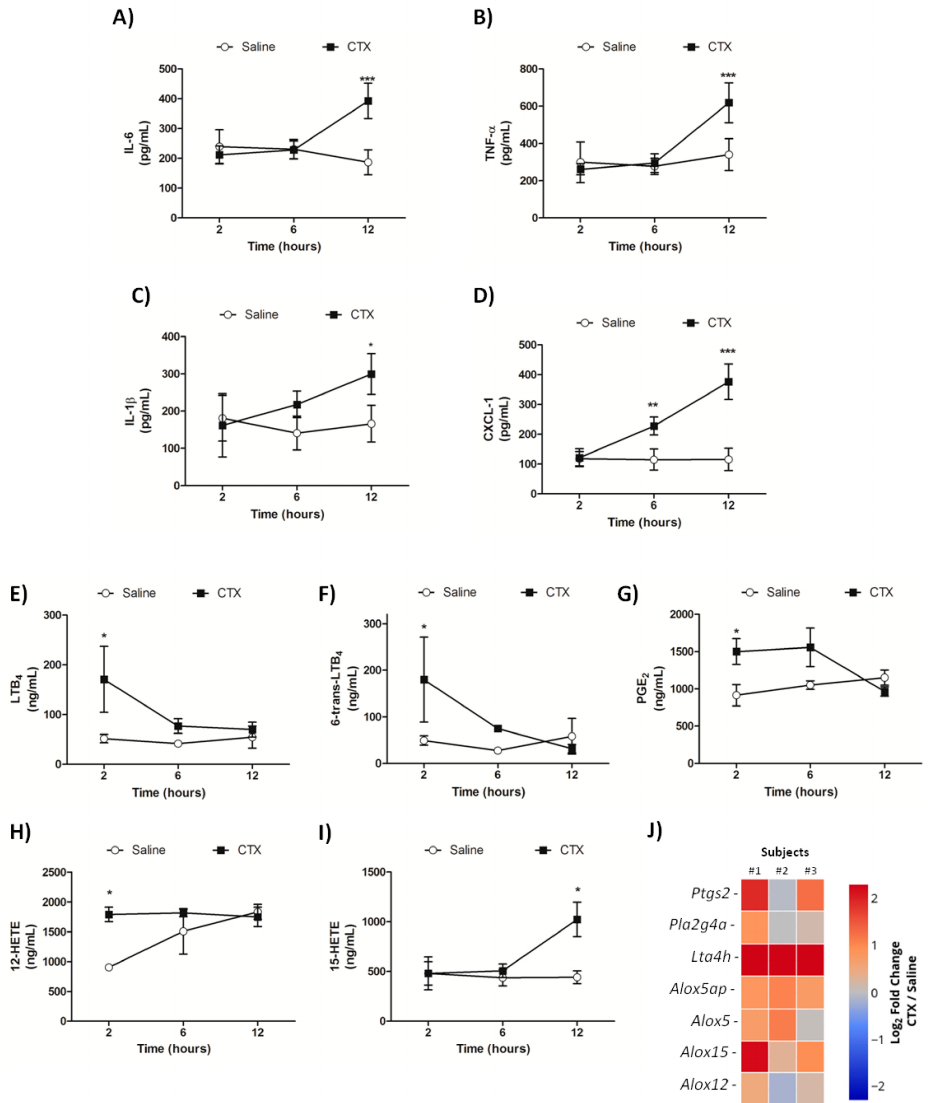
Figure 4. CTX-induced production of inflammatory mediators in mice lung. The animals were treated with CTX (300 µ g / Kg s.c.) for 2, 6, and 12 h, euthanized, and their lungs were removed and homogenized for the quantification of pro-inflammatory cytokines / chemokines ( A – D ) and eicosanoids ( E – I ) using ELISA and LC-MS / MS, respectively. ( A ) Interleukin 6 (IL-6). ( B ) Tumor necrosis factor α (TNF- α ). ( C ) Interleukin 1 β (IL-1 β ). ( D ) Keratinocyte-derived chemokine (CXCL-1). ( E ) Leukotriene B 4 (LTB 4 ). ( F ) 6- trans -Leukotriene B 4 (6- trans -LTB 4 ). ( G ) Prostaglandin E 2 (PGE 2 ). ( H ) 15-Hydroxyeicosatetraenoic acid (15-HETE). ( I ) 12-Hydroxyeicosatetraenoic acid (12-HETE). ( J ) Gene expression profile in mice lung after 2 h of treatment with CTX, assessed by qRT–PCR. Data were expressed as log2 fold-change compared with the control (saline) ( n = 3). The results from ( A – D ) are representative from two independent experiments ( n = 6–7), while the results from ( E – I ) are representative from one independent experiment ( n = 4 animals / group). * p < 0.05, *** p < 0.001 vs. saline treated animals (control) from the respective time group—two-way ANOVA followed by the Bonferroni’s